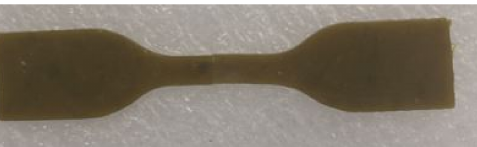
Figure 1. Exemplary ENR/quercetin2/silica15 sample (type 2 according to ISO 37 standard) dedi- cated to mechanical